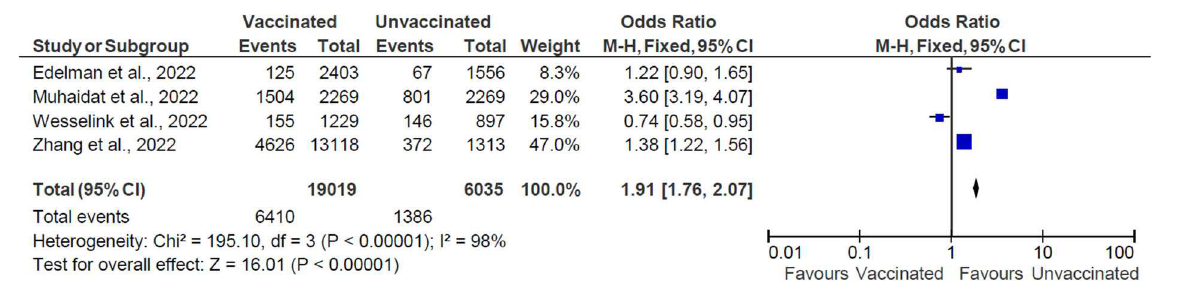
FIGURE2 The effect of vaccination on menstrual cycle changes. M-H, Mantel-Haenszel method; CI, confidence interval; and df, degrees of freedom.